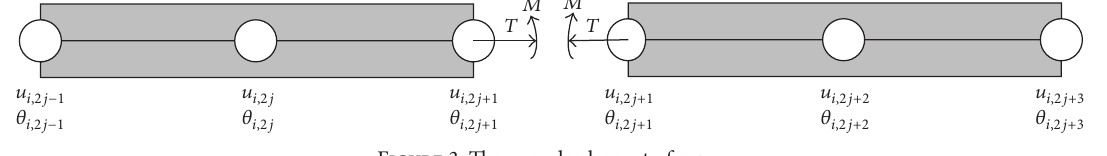
Figure 3: Three-node element of